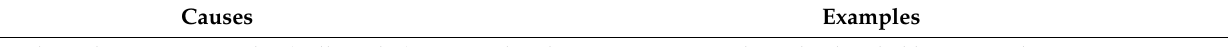
Table 1. Causes of facial nerve